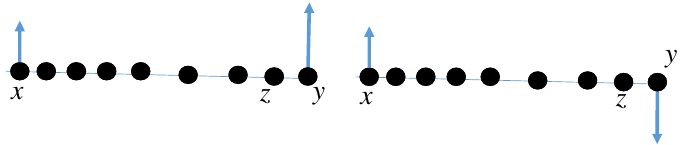
Figure 8. Examples of initially linear